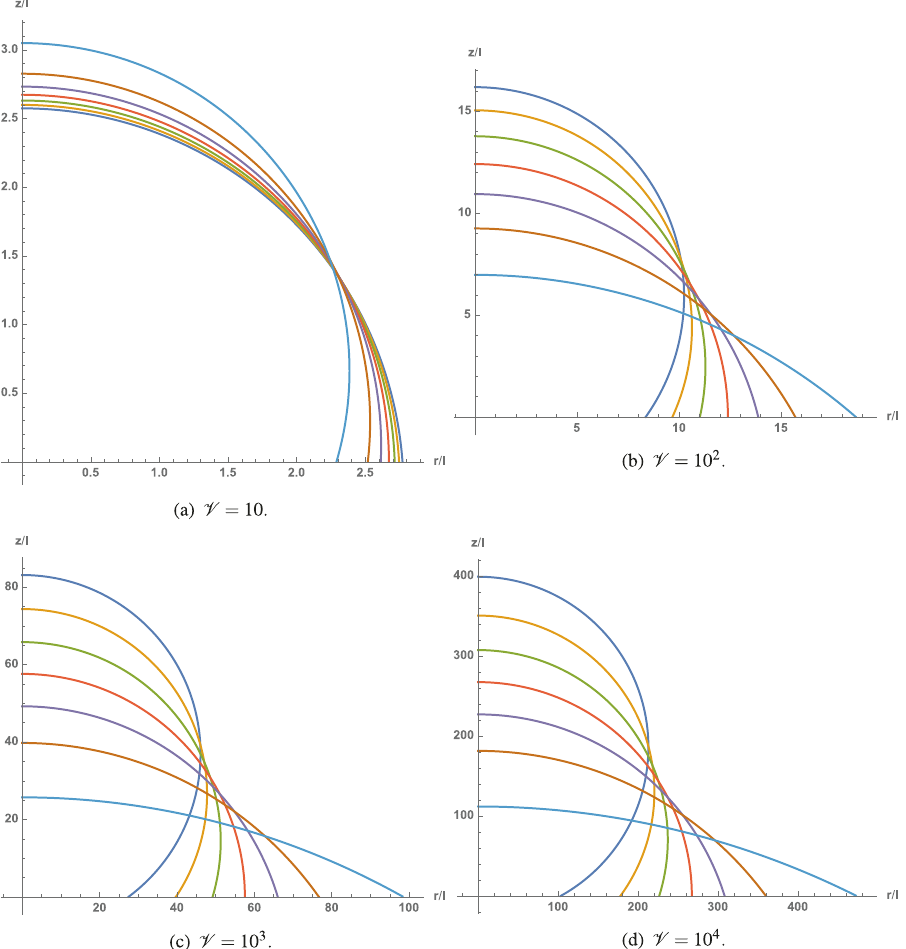
Fig. 6 In fl uence of S on sessile drop shape for four volumes and seven values of S , ranging from − 0.99 (dark blue) to 0.99 (light blue), separated by six equidistant steps. a V ¼ 10 ; ( b ) V ¼ 10 2 ; ( c ) V ¼ 10 3 ; ( d ) V ¼ 10 4